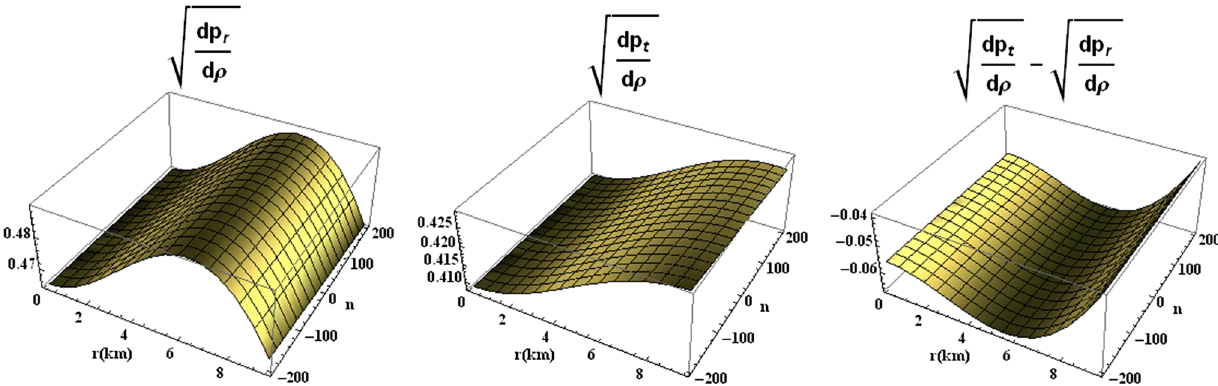
Fig. 7 (Left) Along x -axis, y -axis and z -axis we have respectively plotted the radius of the star in km unit, the dimensionless quantity n which lies in the range − 200 ≤ n ≤ 200 and the radial velocity (cid:27) dp r of sound which is a dimensionless quantity. (Middle) Along x - d ρ axis, y -axis and z -axis we have respectively plotted the radius of the star in km unit, the dimensionless quantity n which lies in the range − 200 ≤ n ≤ 200 and the transverse velocity of sound